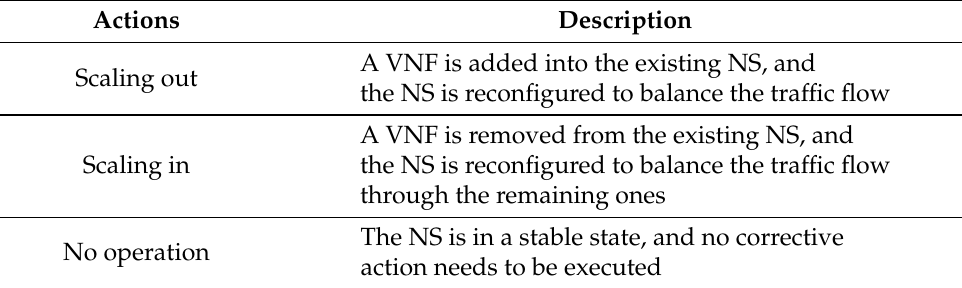
Table 3. Available optimization